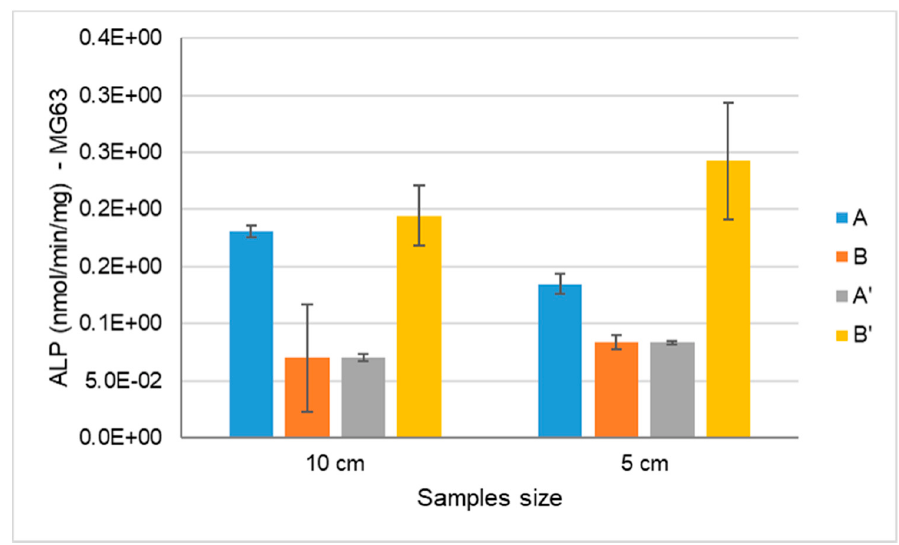
Figure 7. ALP activity of human osteoblast ‐ like cells (MG63) cultured within samples A, B, A’ and B’ for 14 days.